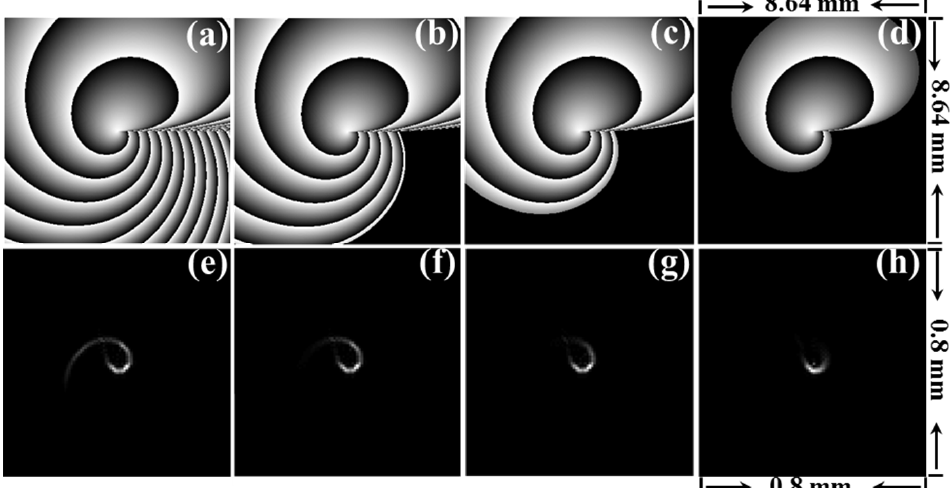
Figure 4. ( a – d ) The tailored exponential phases with l = − 5, n = 0.6, and p = 1, 0.05, 0.1 and 0.15, respectively. ( e – h ) Simulated intensity patterns of the customized spoon-like beams generated with the tailored phases in ( a – d ), respectively.